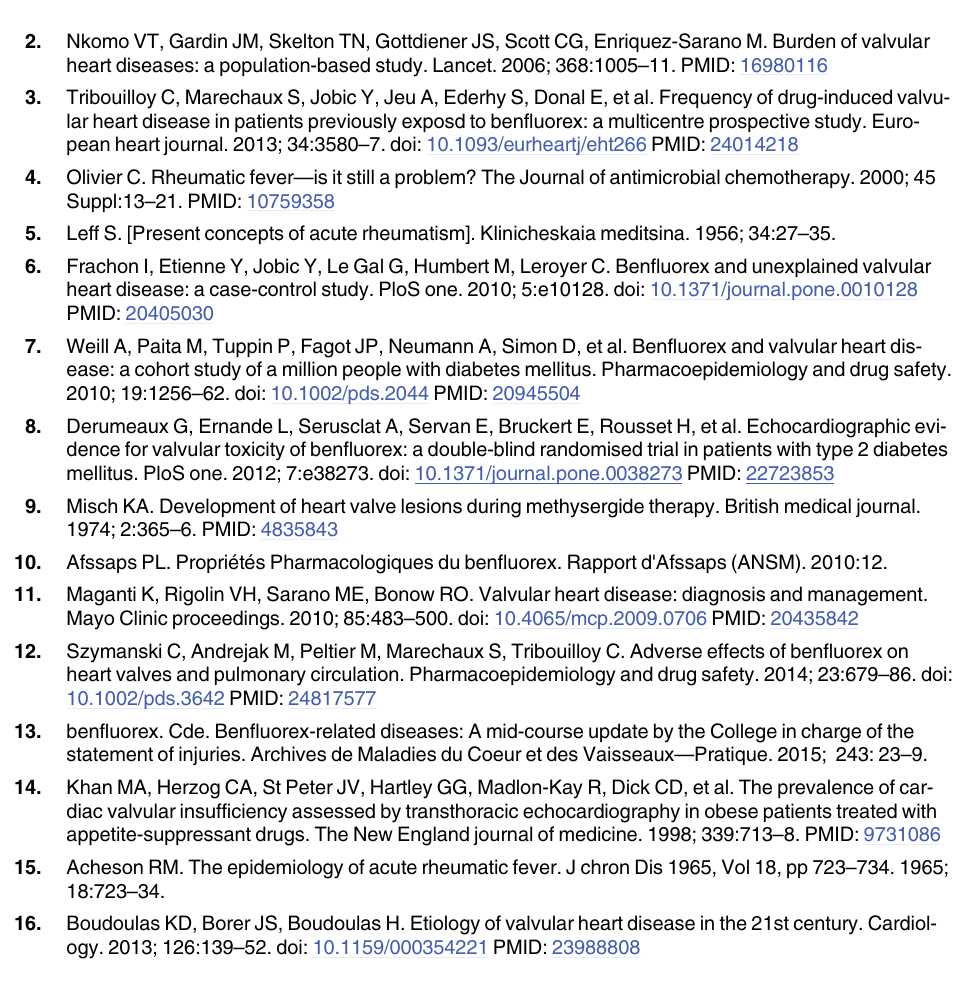
PLOS ONE | DOI:10.1371/journal.pone.0160011 August 3,